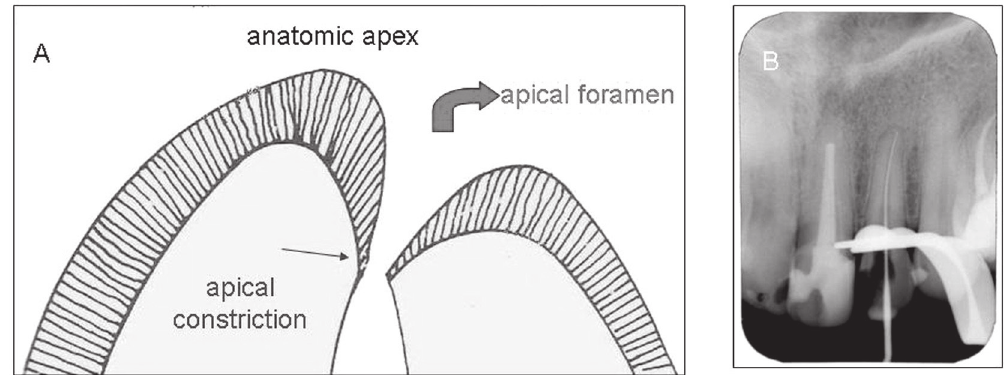
Figure 1- A: Detail of the anatomy of the apical third; B: Conventional radiograph of root canal working length